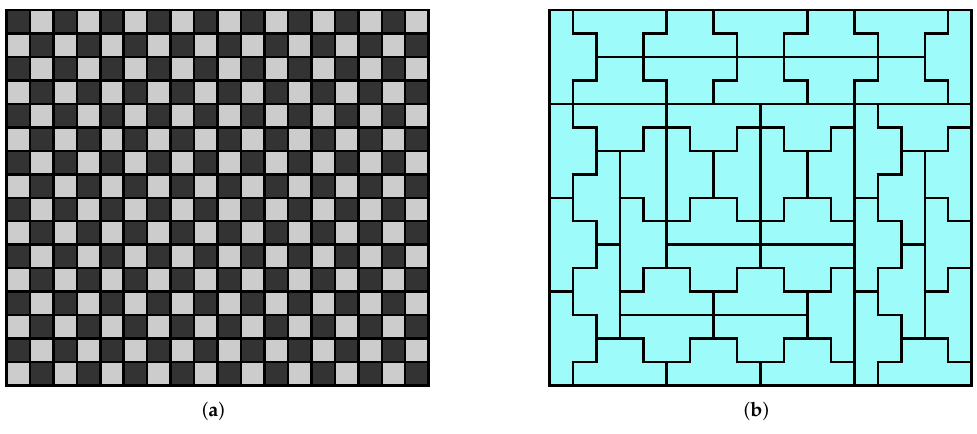
Figure 18. Target region and a tiling solution for Example 6: ( a ) the target region (cid:98) R , a 16 × 18 rectangle; ( b ) successful tiling of the target region (cid:98) R using 48 pariominoes P + corresponding to an optimal solution of the single pariomino tiling